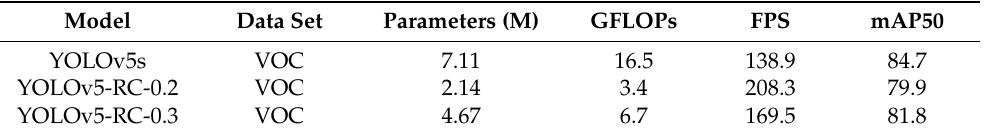
Table 6. Result table of changing the number of channels according to the size of data set.